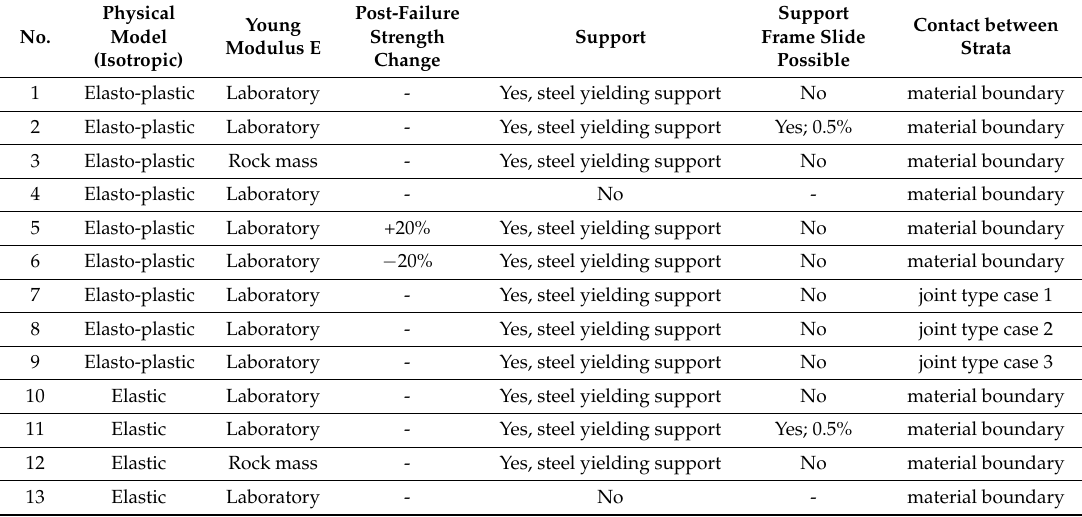
Figure 6. Model plane of the roadway beyond the fault effect. Table 4. Physical models of the rock mass—section beyond the fault zone.